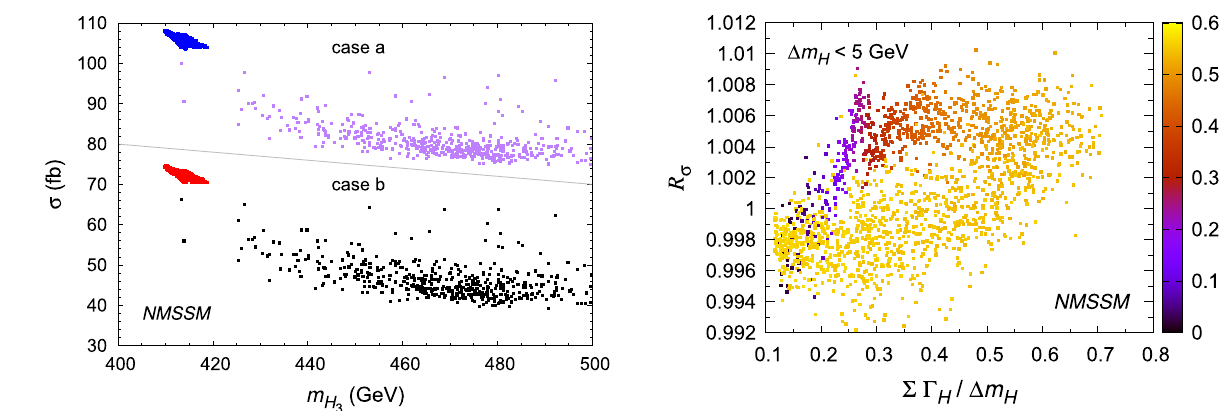
function of the ratio of the sum of the widths of H 2 and H 3 and their mass difference, with the colour map showing the width of H 2 , for the points with (cid:11) m H <